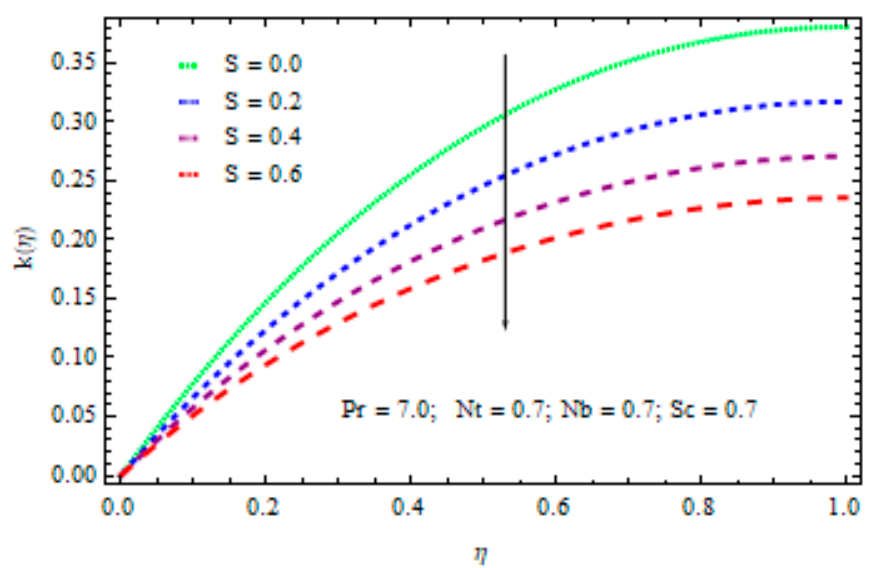
Processes 2019 , 7 , x FOR PEER REVIEW